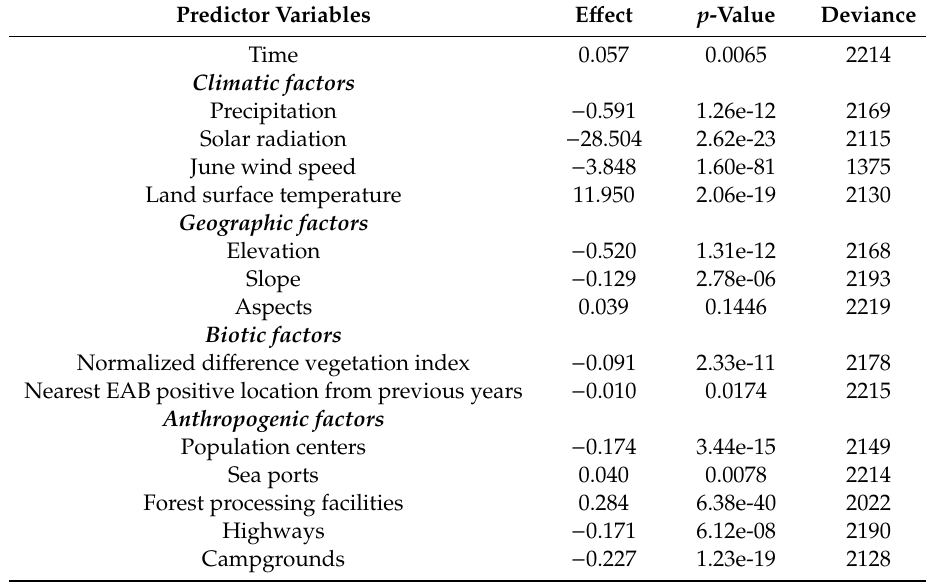
Table 4. The significance level and the goodness of fit by each predictor variable based on the univariate GLMM (Generalized Linear Mixed Model) with the regional random e ff